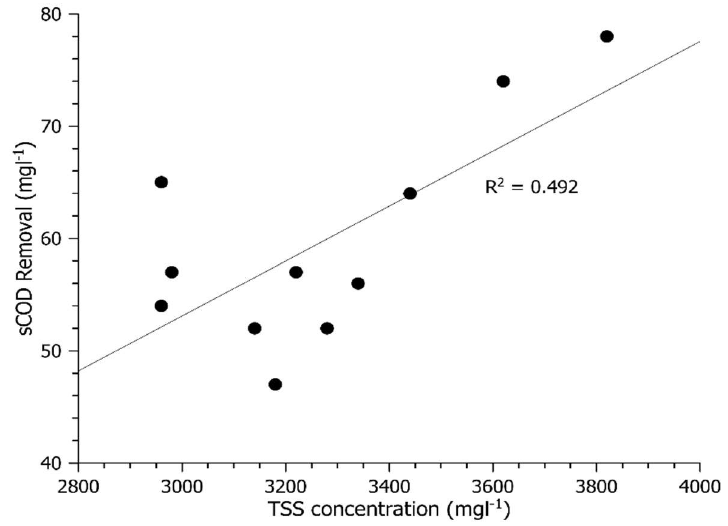
Figure 1. sCOD removal as a function of WAS TSS during 30-min of biosorption.